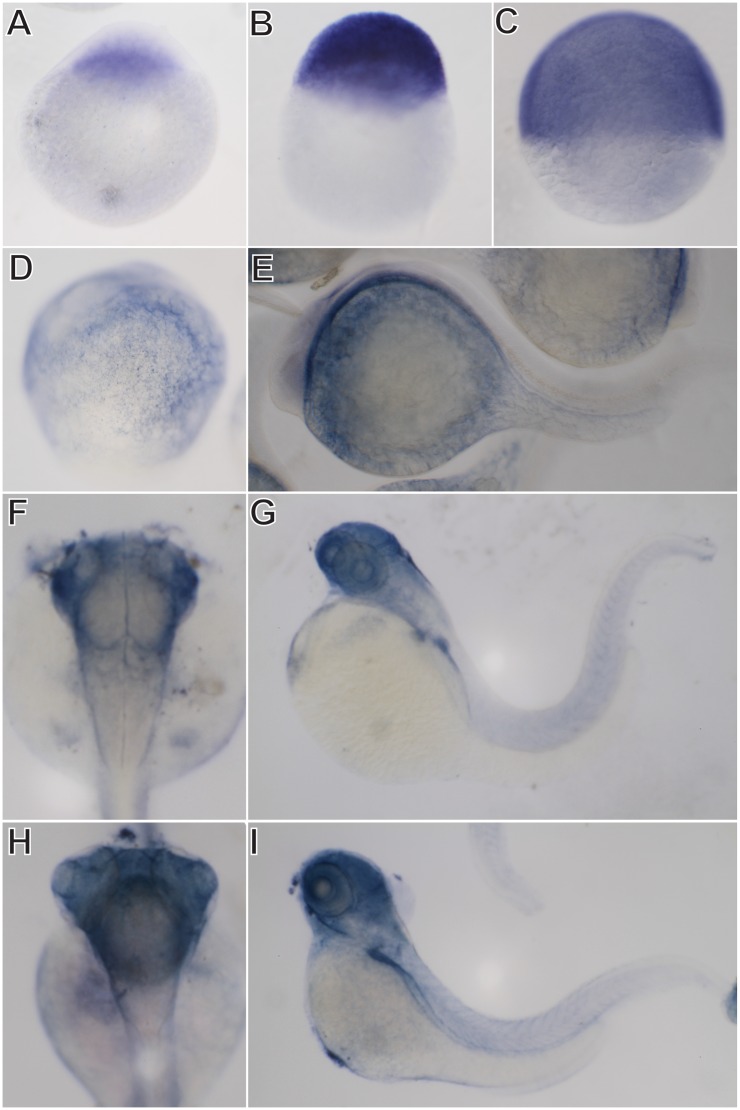
Expression patterns of zebrafish soat1 during embryogenesis.Whole-mount in situ hybridization shows that soat1 can be detected in all blastomeres at 1 cell stage (A), 3 hpf (B), and 6 hpf (C). The expression of soat1 was prominent at yolk sac at 12 hpf (D) and 24 hpf (E). By 48 hpf (F, G), soat1 was detected in the brain, retina, pectoral fin, hatching gland and pericardium. By 72 hpf (H, I), soat1 was also observed prominently in the liver primordia and intestine.